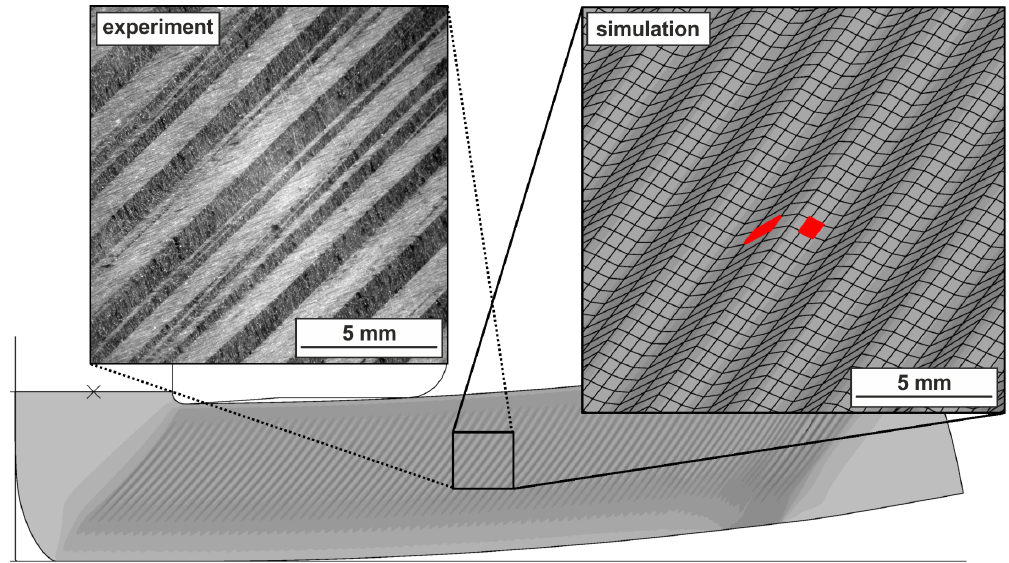
Figure 14. Comparison of shear and matrix bands in simulation ( right ) and experiment ( left ). In the optical micrograph, the shear bands are shown in bright and the matrix bands in dark gray. In the simulation, the opposite is the case: The shear bands are depicted in dark and the matrix bands in bright gray. Additionally, the positions of the chosen elements in the billet far away from all boundaries are shown in